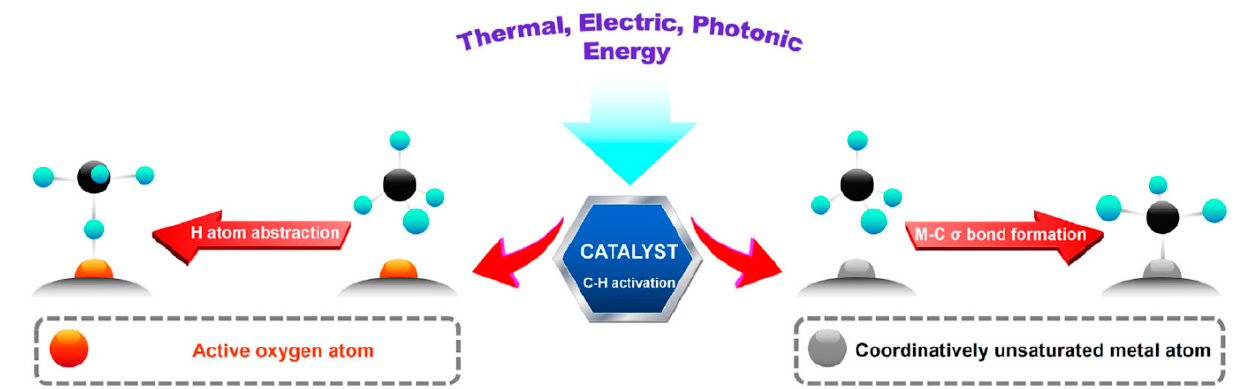
Figure 3. The mechanism of the C–H bond cleavage of CH 4 at low temperature can be classified into two categories. Reproduced from [9] with permission. Copyright 2019 Elsevier.